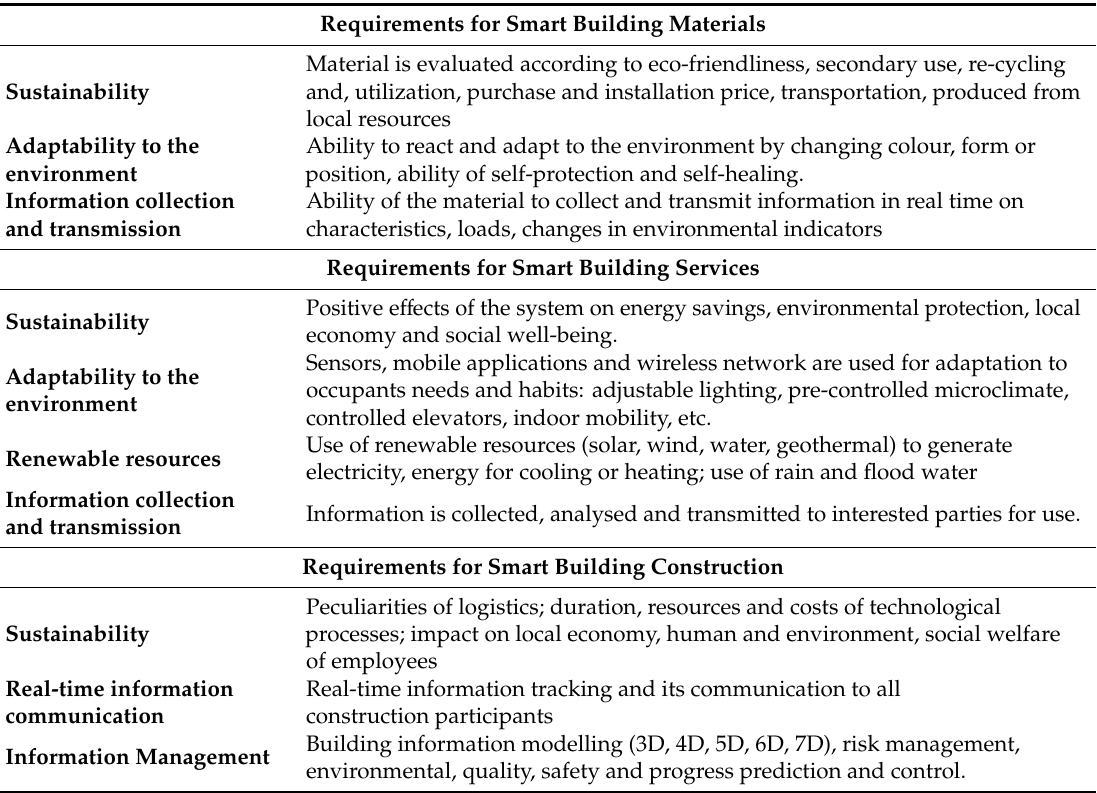
Table 5. Requirements for smart building materials, services, and